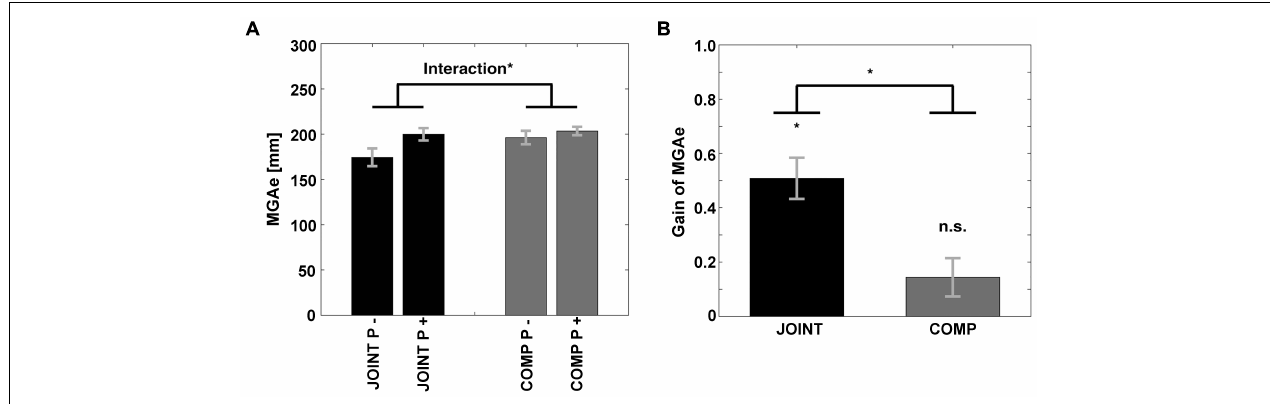
FIGURE 4 | (A) Size of MGAe during cooperation (JOINT) and competition (COMP) for perturbation (P+, i.e., left and right object rotations collapsed) and no-perturbation (P–, i.e., up and down rotations collapsed) trials. (B) Scaling of MGAe to different object widths for cooperation (JOINT) and competition (COMP). Gain = [MGA of object width in P+ trials – MGA of object width in P– trials] / [P+ object width – P– object width]. Error bars indicate standard error. ∗ Indicates significance at p < 0.05.